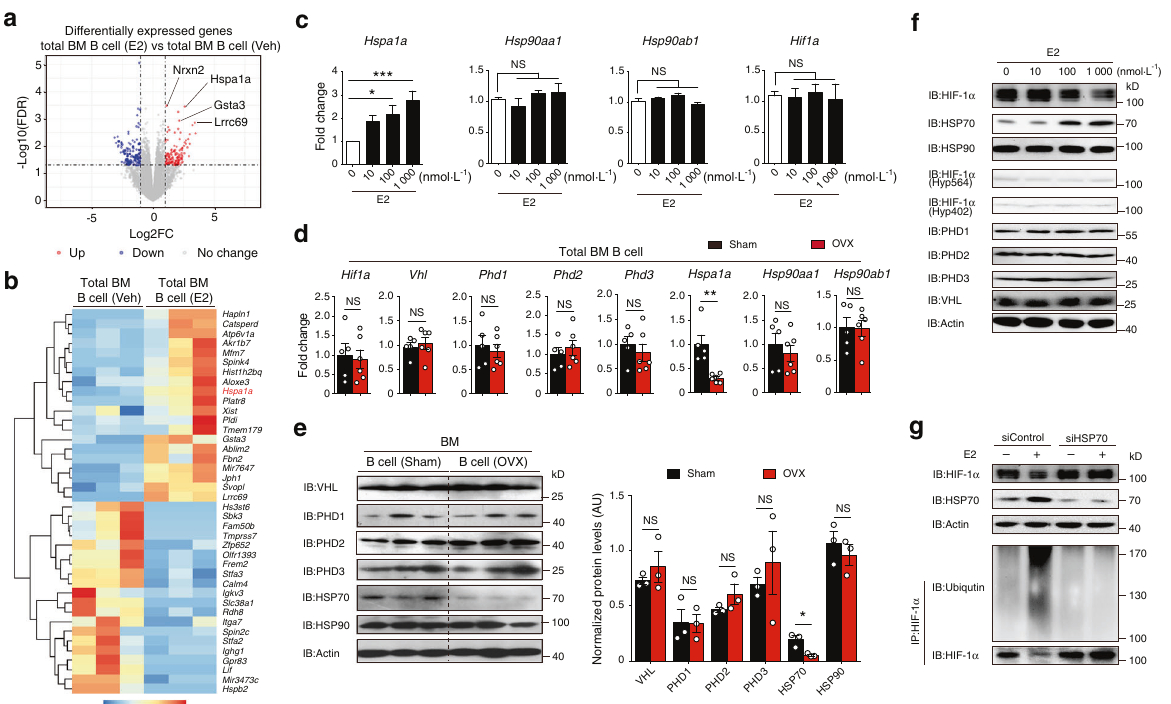
Fig. 4 Estrogen controls HIF-1 α stabilization via the HSP70-mediated degradation pathway. a Volcano plot of RNA-seq analysis of estrogen (E2) (1 μ mol·L − 1 )-treated versus vehicle (Veh)-treated WT bone marrow B cells under hypoxic conditions showing genes upregulated and downregulated, respectively, with a fold change (FC) higher than 2. b Heatmap of differentially expressed genes found within gene sets displayed in ( a ). c Hspa1a , Hsp90aa1 , Hsp90ab1 and Hif1a mRNA expression in B cells treated with the indicated concentration of estrogen (E2) under hypoxia for 12 h ( n = 3). Values for the control group were set as 1. d Hif1a , Vhl , Phd1 , Phd2 , Phd3 , Hspa1a , Hsp90aa1 , and Hsp90ab1 mRNA expression in B cells from the bone marrow of sham control (Sham) and ovariectomized (OVX) mice. e Levels of VHL, PHD1, PHD2, PHD3, HSP70, and HSP90 protein in isolated B cells from the bone marrow of OVX and Sham control mice ( n = 3). f HIF-1 α , HSP70, HSP90, hydroxylated HIF-1 α (P564 and P402 sites), PHD1, PHD2, PHD3, VHL and β -actin expression in isolated bone marrow B cells with the indicated concentration of estrogen (E2) treatment under hypoxic culture for 24 h. g HIF-1 α , HSP70 and β -actin expression in bone marrow B cells transfected with control or HSP70 siRNA lentivirus under hypoxic culture for 24 h. MG132 (100 μ mol·L − 1 ) was added to HIF-1 α immunoprecipitation samples. * P < 0.05, ** P < 0.01, *** P <